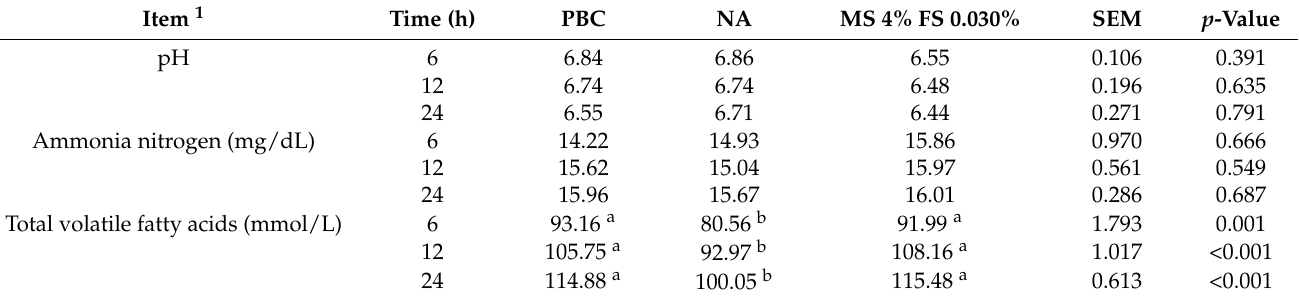
Table 5. Fermentation end-products of both pre-ensiled materials and ensiled forms at three time points (6, 12, 24 h) during the in vitro rumen